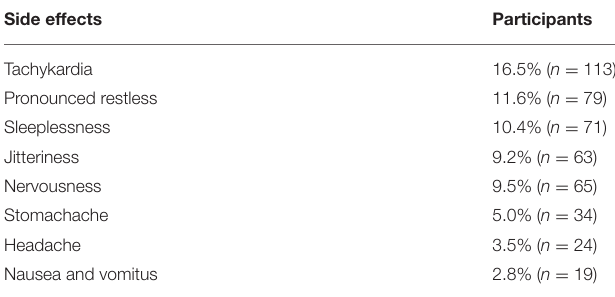
TABLE 7 | Side effects.